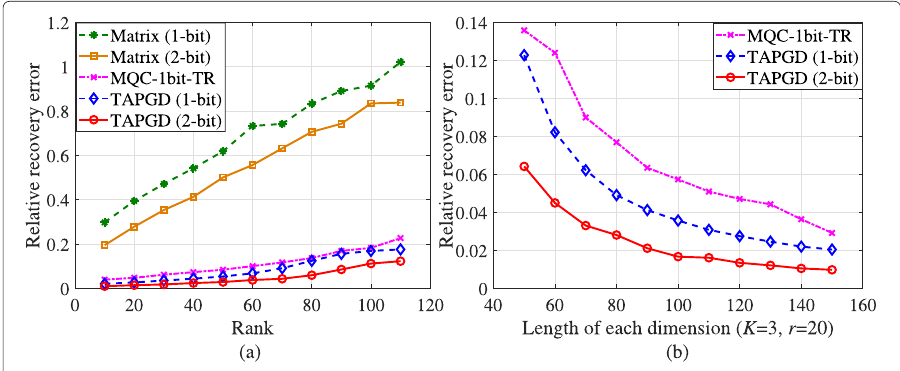
Fig. 2 Recovery performance on general tensor. a Relative recovery error when rank changes. b Relative recovery error when dimension